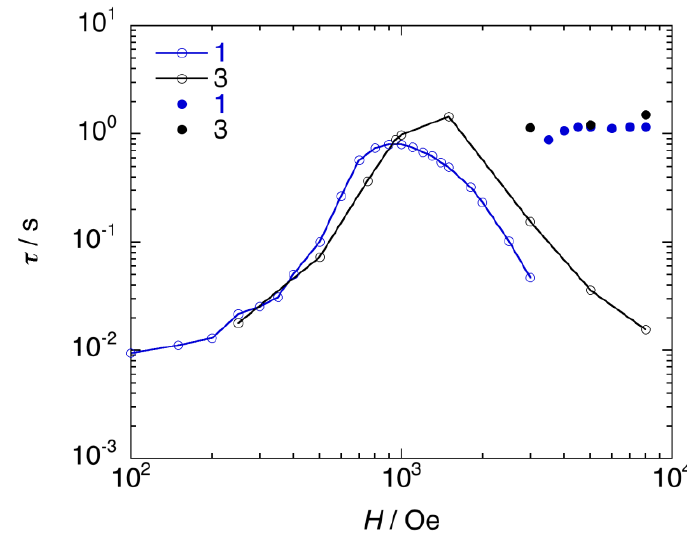
Figure 6. H DC -dependece of τ for 1 and 3 at 1.8 K indicating two distinct relaxation processes: H DC -dependent component (blue open circles for 1 and blue open circles for 3 ) and H DC -independent ones (blue filled circles for 1 and black filled circles for 3 ). Solid lines serve as guides. Both 1 and 3 show ν-dependent χ M at their respective optimum H DC . The relaxation time (τ) can be extracted at each blocking temperature using a generalized Debye model (Figure 7). Here,